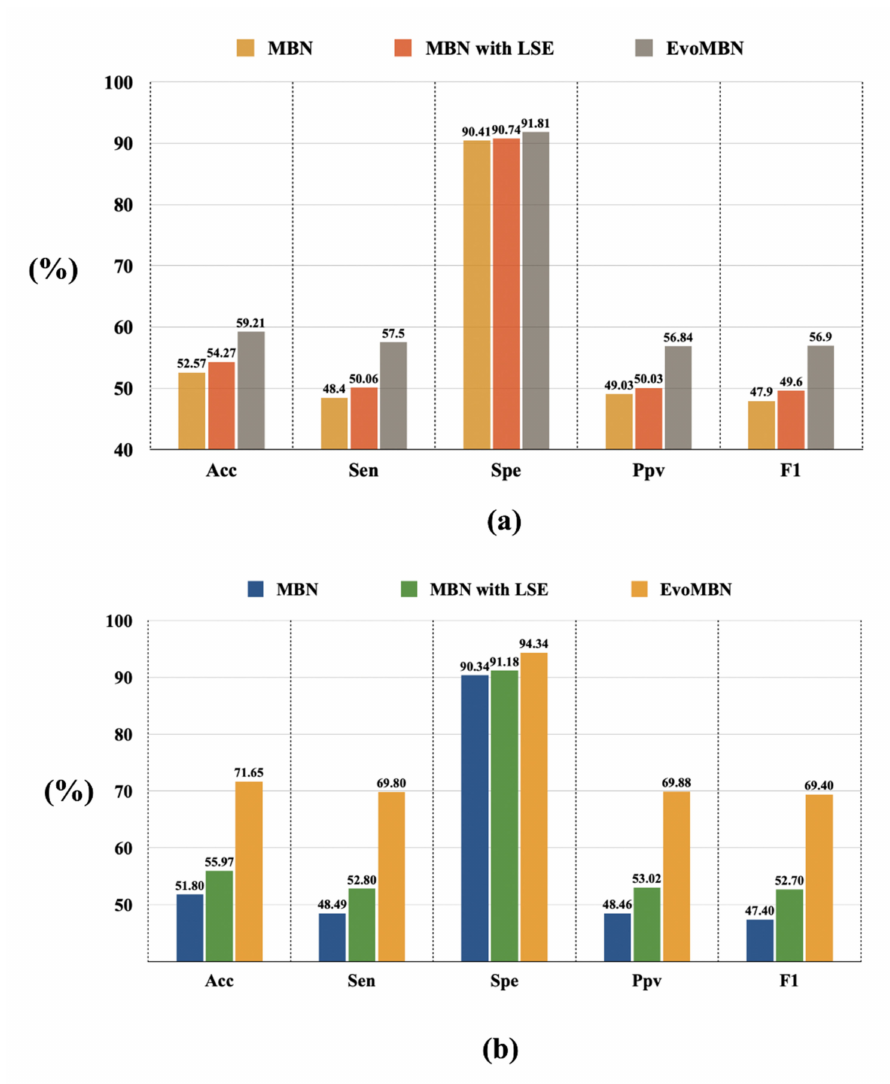
Figure 13. The results of the ablation experiment on MI localization. ( a ) Based on a single multi-class classifier ( b ) Based on a group of binary